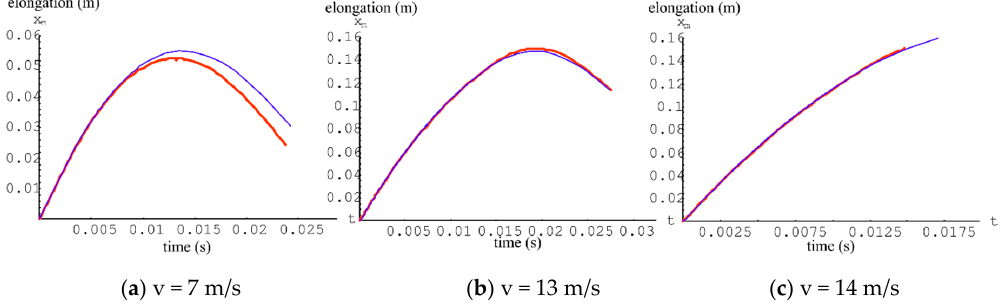
Figure 8. Elongations at various initial velocities (v = 7 m/s, 13 m/s, 14 m/s). Number of segments = 15, red line: approximate solution, blue line: exact solution.